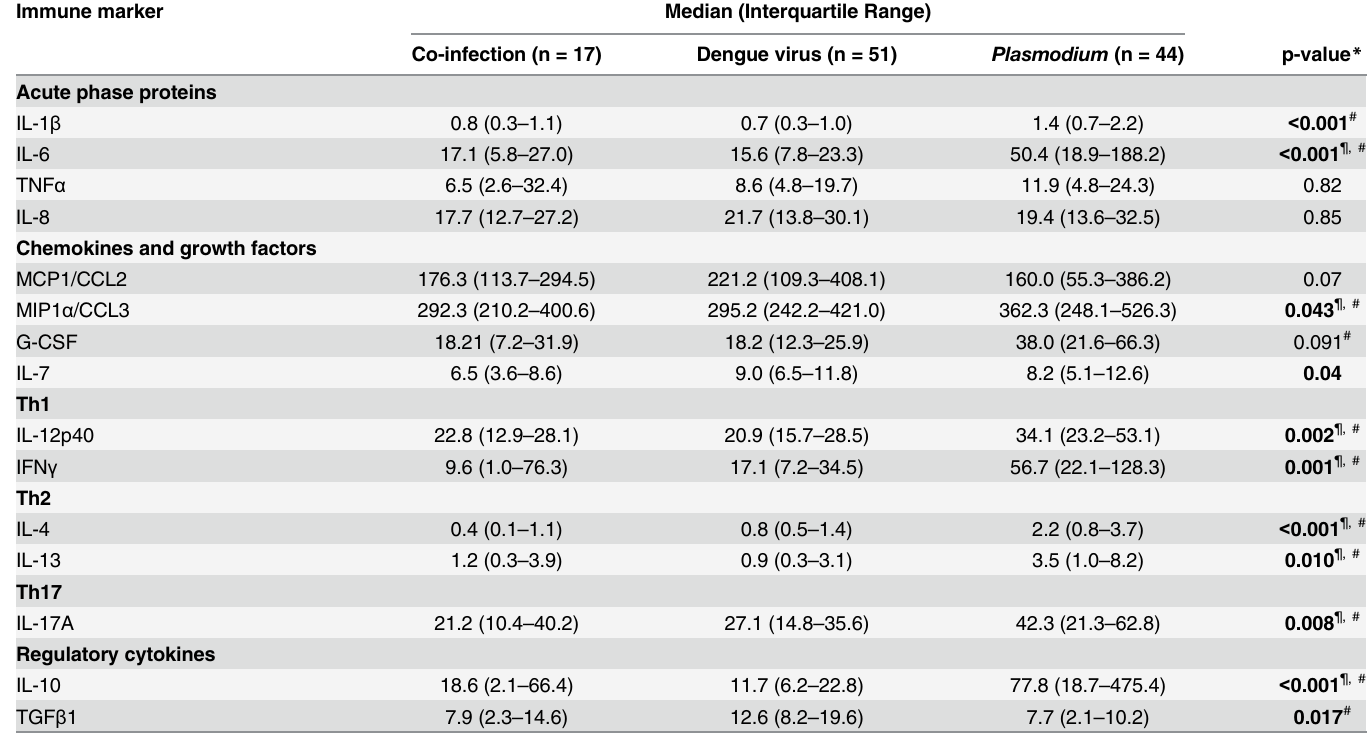
* Overall comparison across all three groups using a mixed-random effect regression model after adjusting for patient age and number of days with fever ¶ p < 0.05 when comparing co-infected and Plasmodium mono-infected groups in the